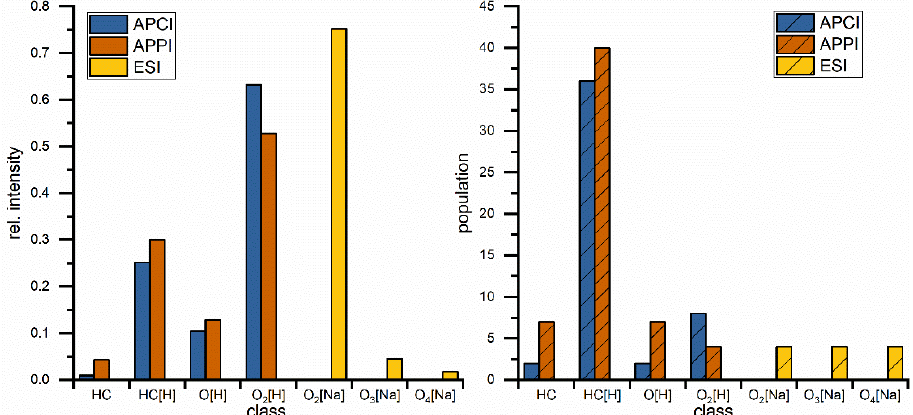
Figure 3. Comparison of direct injection measurements regarding class distribution for different hydrocarbon classes with rel. intensities ( left ) and population ( right ) which represents the number of assigned elemental compositions. Classes are describing hydrocarbons with different (number of) heteroatoms. Square brackets contain the adduct type, no brackets represents radical ions.